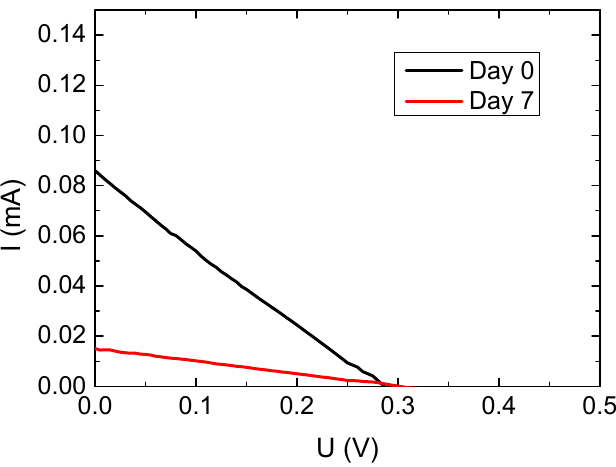
Figure 3. Current-voltage ( I - U ) characteristics of a glass/nanofiber mat DSSC, prepared with an anthocyanin-based dye. The y-axis differs from Figure 2.